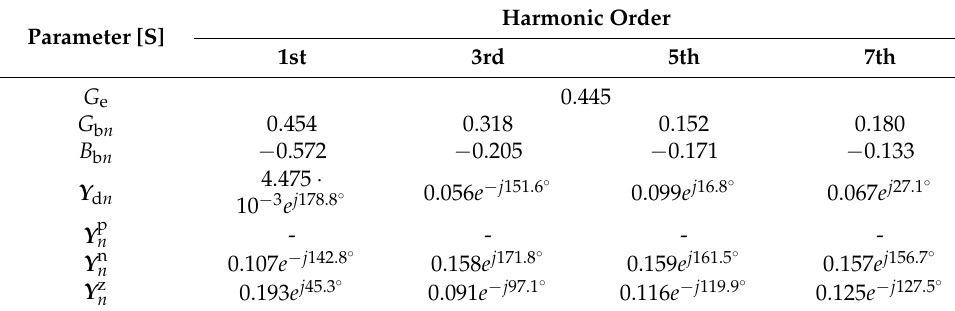
Figure 4. The three-phase current waveforms of the load. Table 3. List of the values of the individuals admittances.